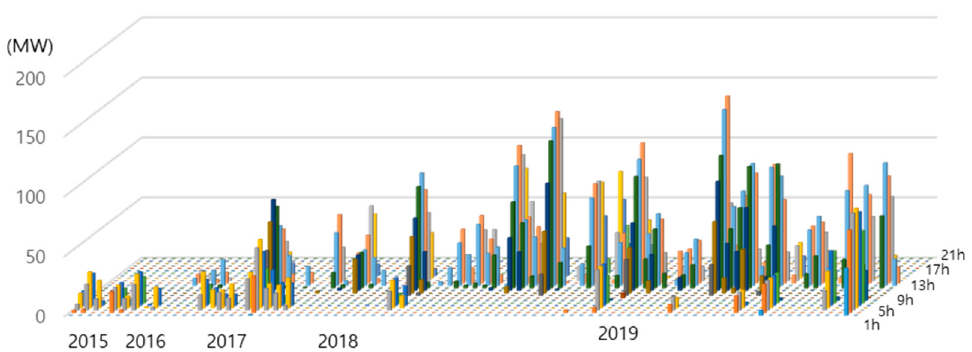
Figure 8. Renewable energy curtailment without an ESS.